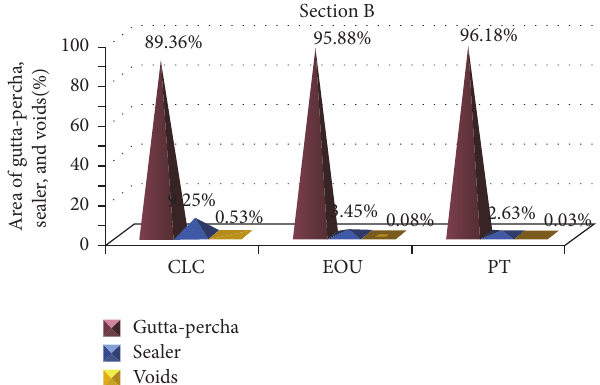
Figure 5: The percentage of the canal area filled with gutta-percha, sealer, and voids after using three gutta-percha techniques, section B.